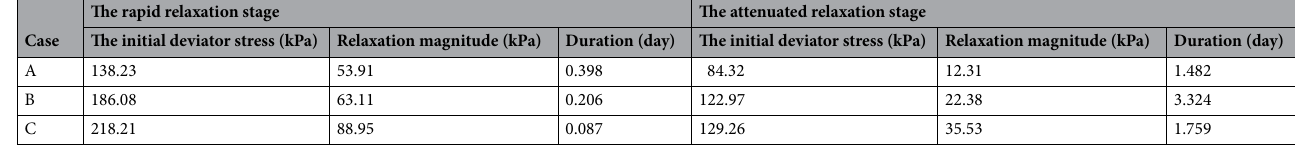
Table 4. The characteristics in two relaxation